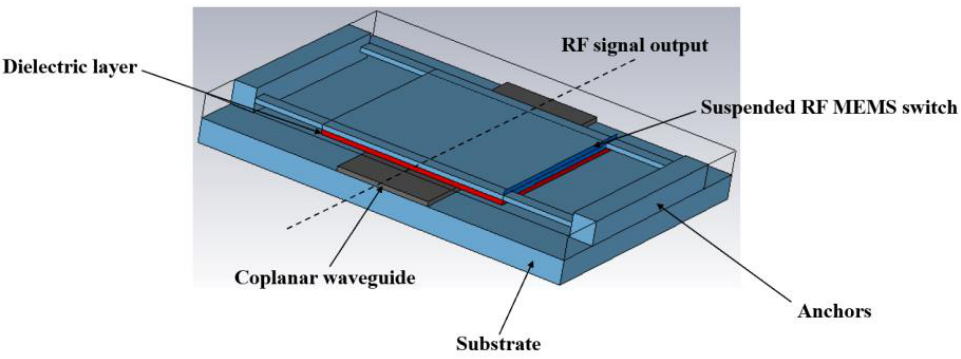
Figure 3. 3D schematic of the RF-MEMS capacitive switch.